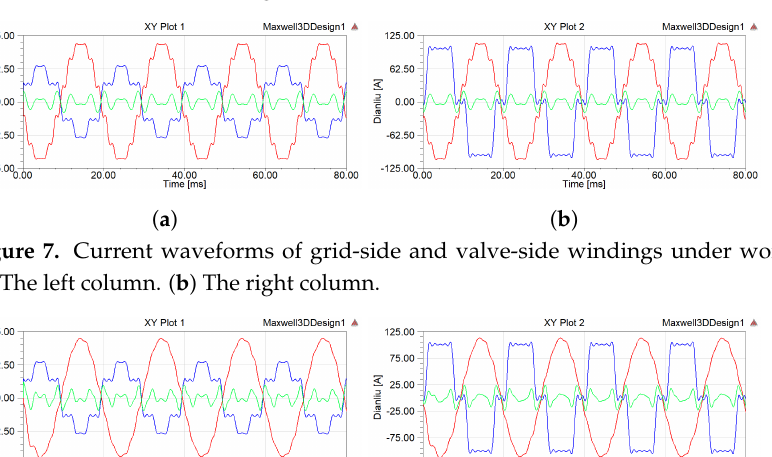
Figure 6. Current waveforms of grid-side and valve-side windings under working condition 1. ( a ) The left column. ( b ) The right column.